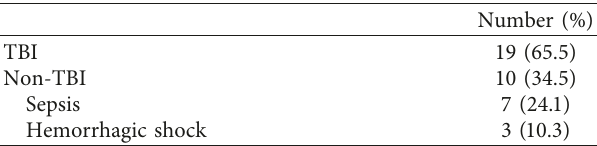
Table 4: Causes of deaths.